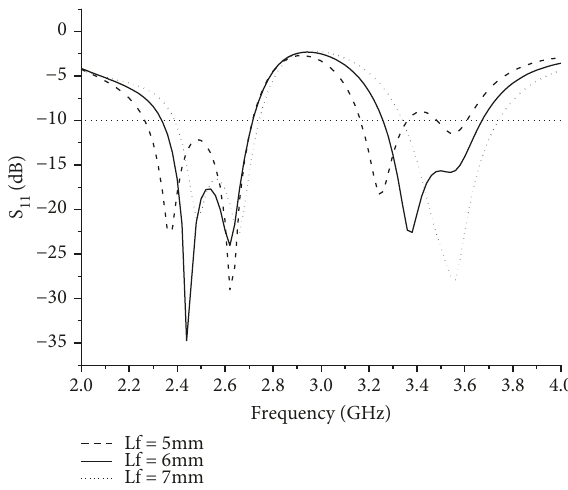
Figure 7: Simulated S